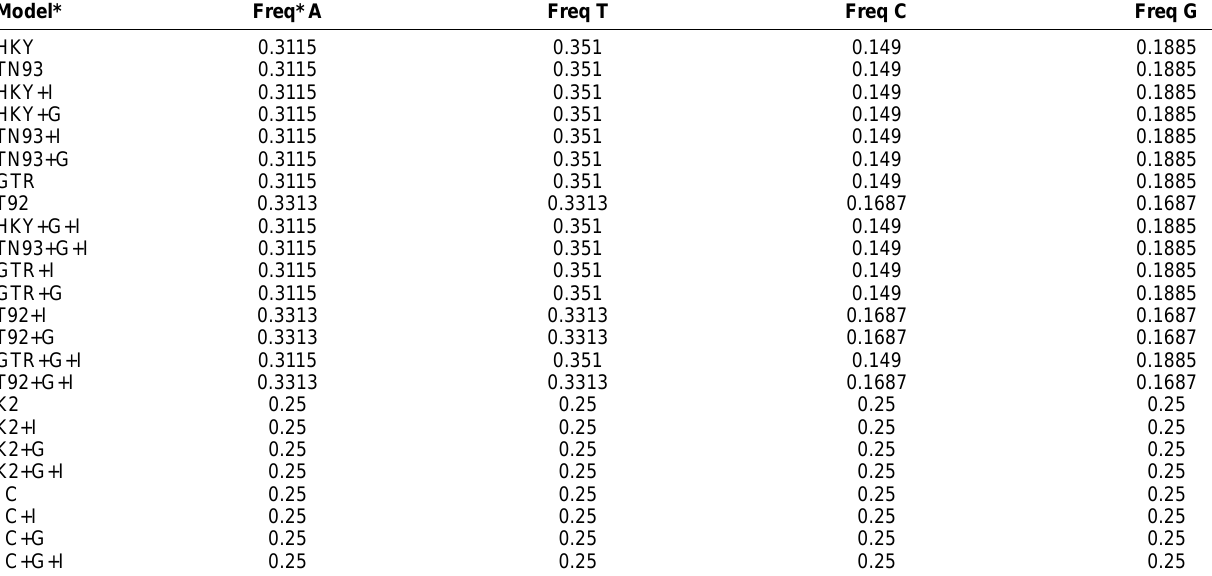
Table-4. The frequency of four different nucleotides in Intron I of OLR1 gene in Buffalo.